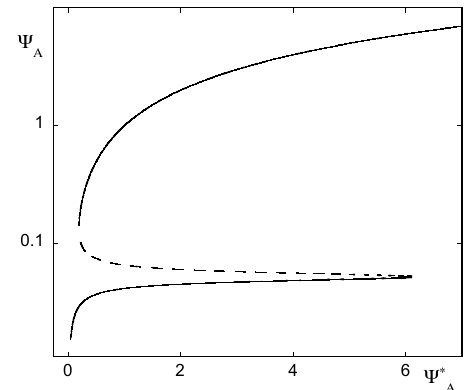
Figure 9. Bifurcation diagram of model (17) as parameter ψ ∗ creases from 0.05 to 7. Full lines represent the two stable solu- tions, blocked (lower), zonal (upper) and dashed line the inter- mediate unstable state. Parameter values k = 10 − 2 , β = 0 . 1, h 1 = √ 1 . 6 2 /( 3 π) , h 2 = h 1 / 5 and α = 8 h